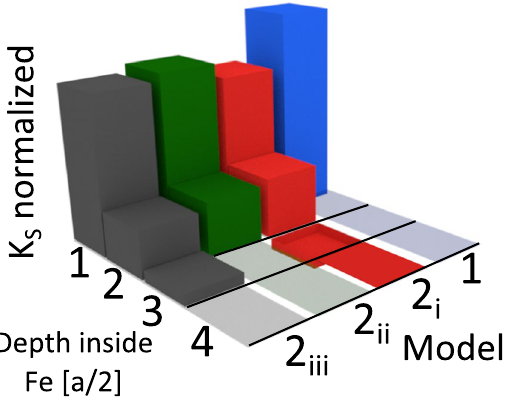
Figure 4. Sketch of the different possible distributions of the surface anisotropy K s 1 explored in simulations. Blue prism represents PMA variation within model M1. Three possibilities within models M2(i–iii) explored are represented correspondingly by red, green and grey coloured prisms respectively. The total volume energy corresponding to PMA has been kept